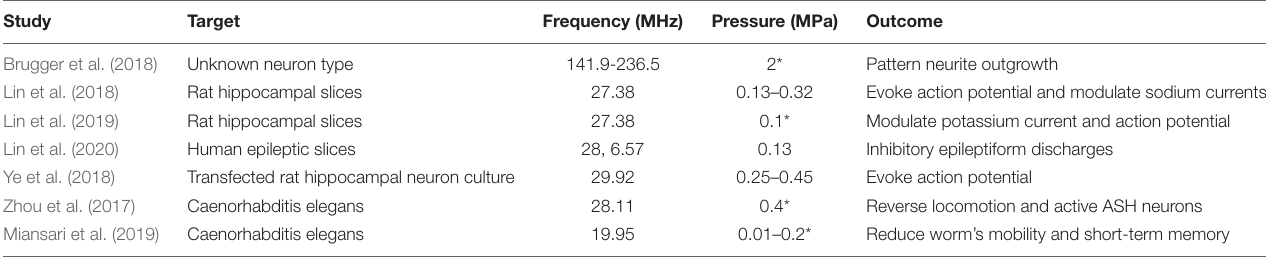
TABLE 1 | Summary of the acoustic parameters used in stimulating neurons via